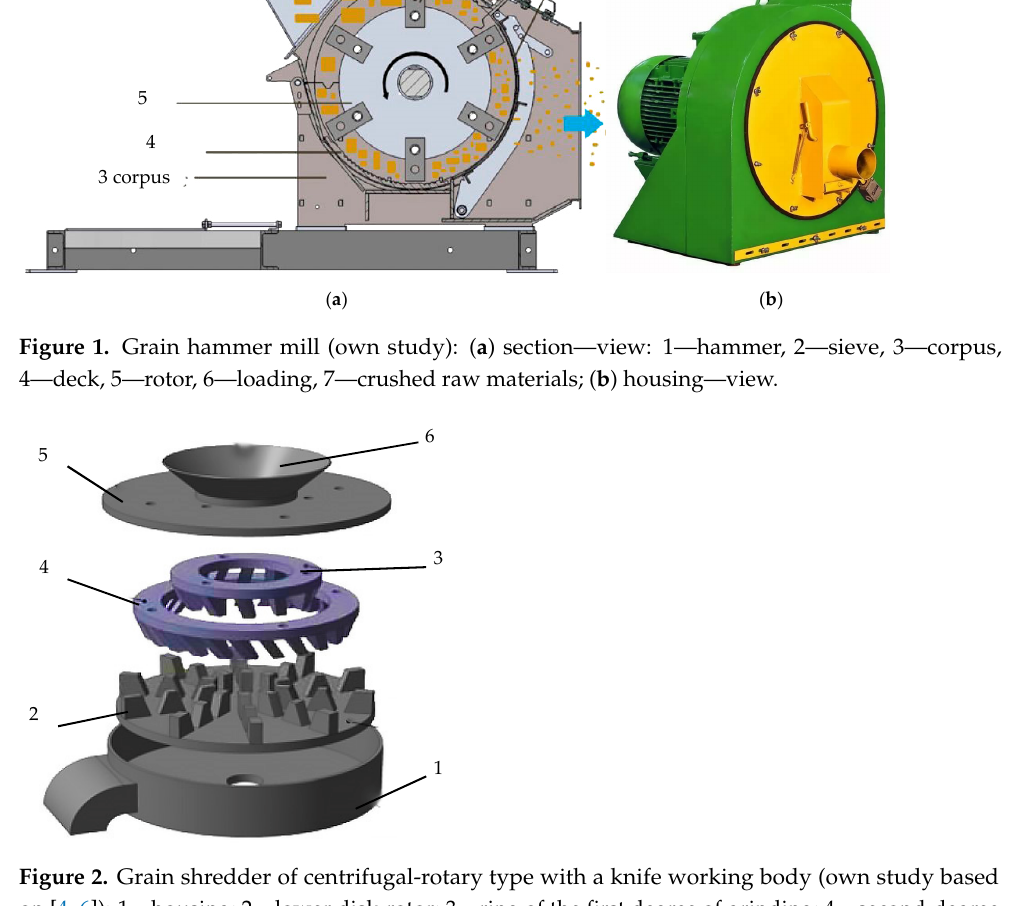
Figure 3. Disintegrator (shock-centrifugal shredder) with intermediate separation in a centrifugal field (own study based on [7]): 1—housing; 2—loading funnel; 3—exit hole; 4—the upper disc; 5— counter rotating disk; 6—flat element of the I-th row; 7—percussive elements of the intermediate row; 8—flat shock elements of the last row; 9—ring; 10—set of knives of the i-th row; 11—upper shaft; 12—lower shaft; 13—casing; 14—cone; 15—ower disk. The theory of similarity and dimensional analysis are applied. The experiment was carried out in order to obtain the actual values of dimensionless coefficients and expo- nents in the derived empirical dependence applicable to the considered design of the ro- tary centrifugal grinder. The aim of the presented research is to establish the relationship between the com- pleted design and the technological parameters of the centrifugal-rotary work with the